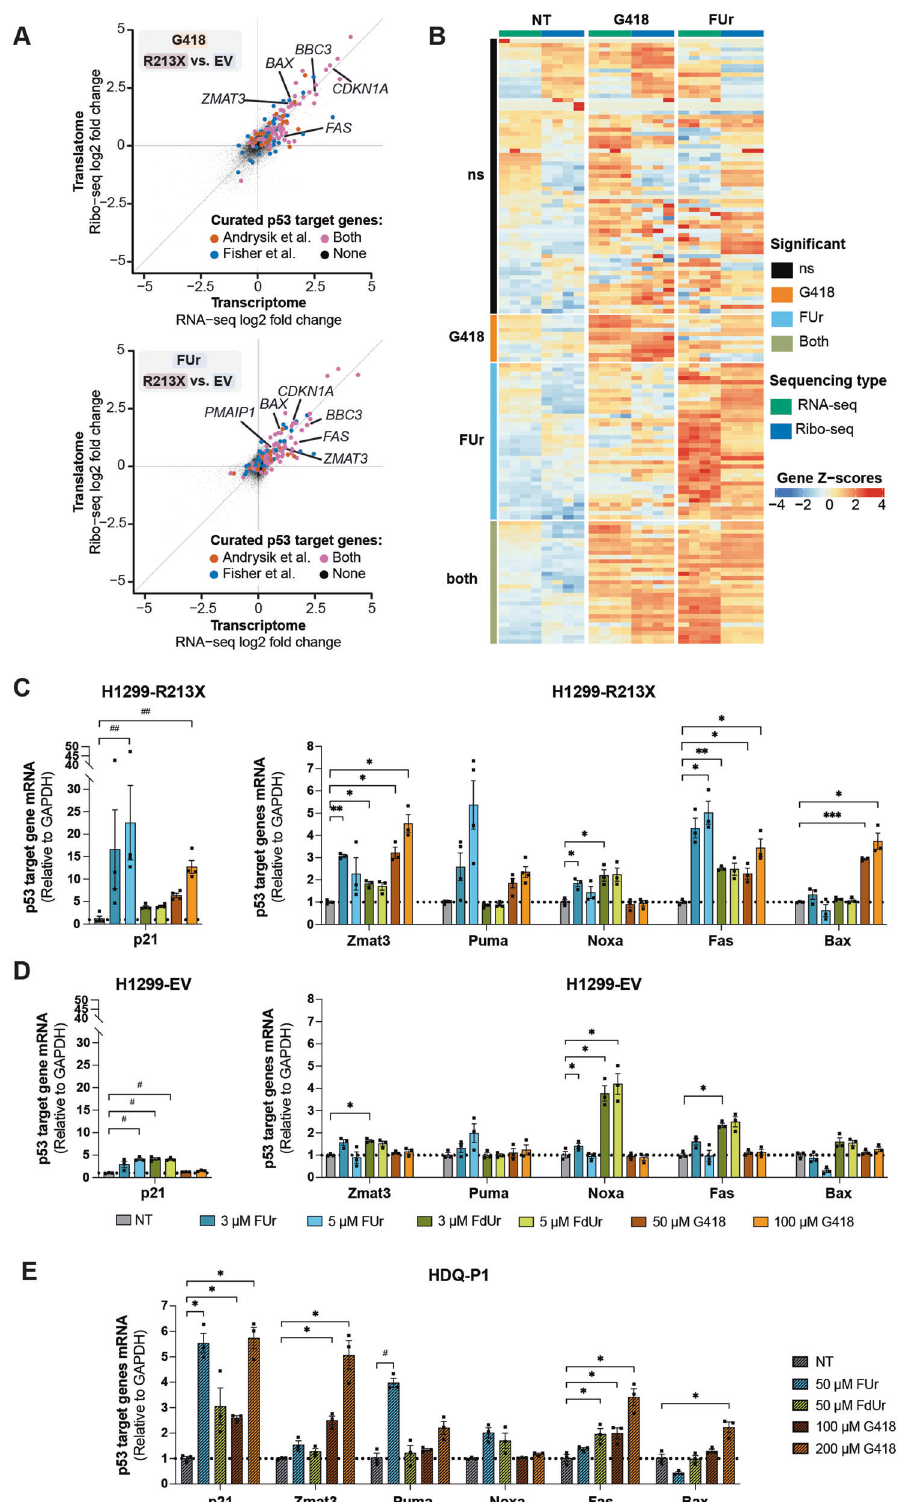
5-FU or FUr for 5 days was suf fi cient to induce detectable levels of full-length p53 in vivo in H1299-R213X-FLAG xenografts (Fig. 7C- D). p53 expression, detected by FLAG antibody, was the highest in tumors from three of the FUr-treated mice (ID 10, 11 and 12), but was also elevated in tumors from 5-FU-treated mice. Detectable